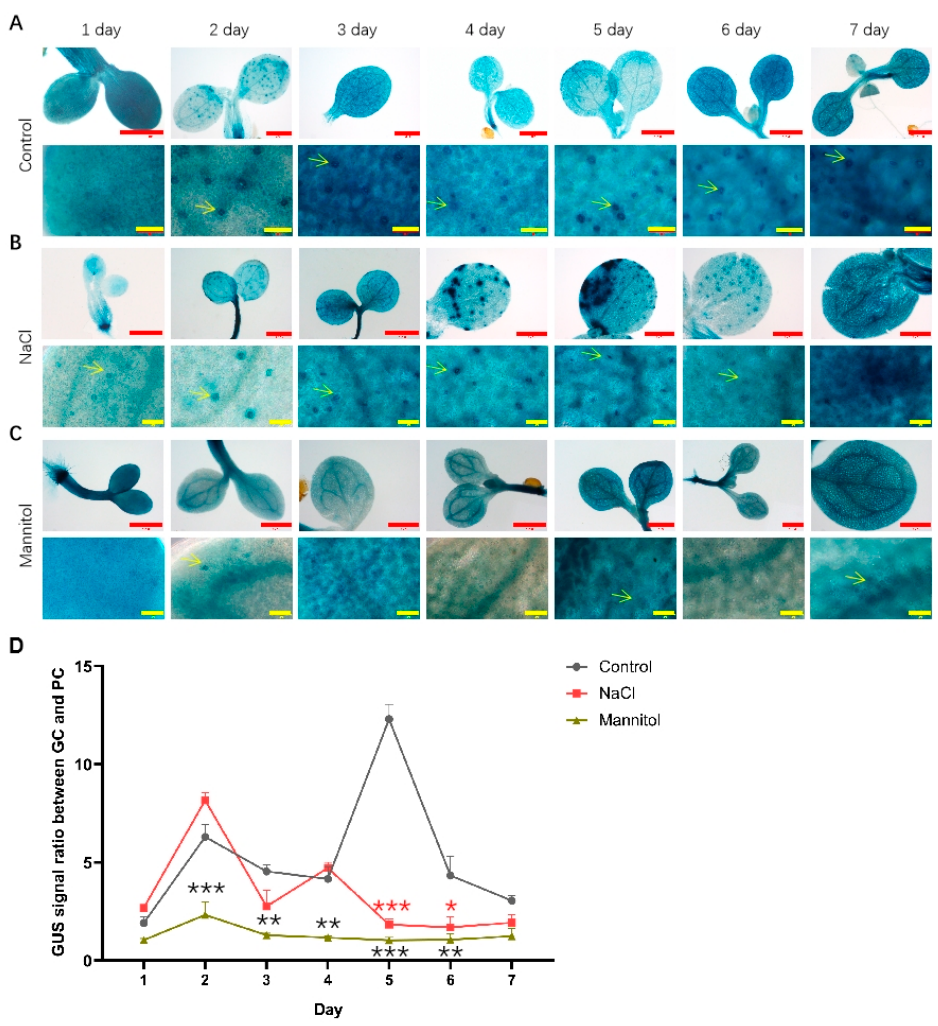
Figure 2. Analysis of the expression of PIF4pro:GUS after being treated with NaCl and mannitol. Analysis of the expression of PIF4pro:GUS in whole cotyledons (up panel) and lower epidermis during development of seedlings grown under control ( A ), NaCl ( B ), and mannitol ( C ) conditions, respectively. The seedlings of PIF4pro:GUS were grown in 1/2 MS plates plus 100 mM NaCl or 150 mM mannitol for 1–7 days, respectively; the seedlings of PIF4pro:GUS grown in normal ½ MS plates were used as controls. Then the seedlings were harvested and used for detecting the GUS activities by GUS staining, as described in Materials and Methods. Scale bar: red bar 1 mm, yellow bar 50 μ m. ( D ) Statistical analysis of the ratio of GUS signal in GC vs. PC. The data were analyzed by one-way ANOVA following Brown–Forsythe test. *: p < 0.05; **: p < 0.01; ***: p < 0.001. Red star: NaCl vs. control; black star: mannitol vs. control.